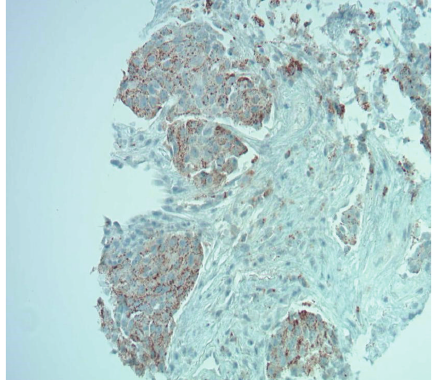
Figure 5: Thyroid biopsy: Napsin A immunostain 200x in neck mass. Napsin A is sensitive and specific for pulmonary adenocar- cinoma. Tumor is negative.